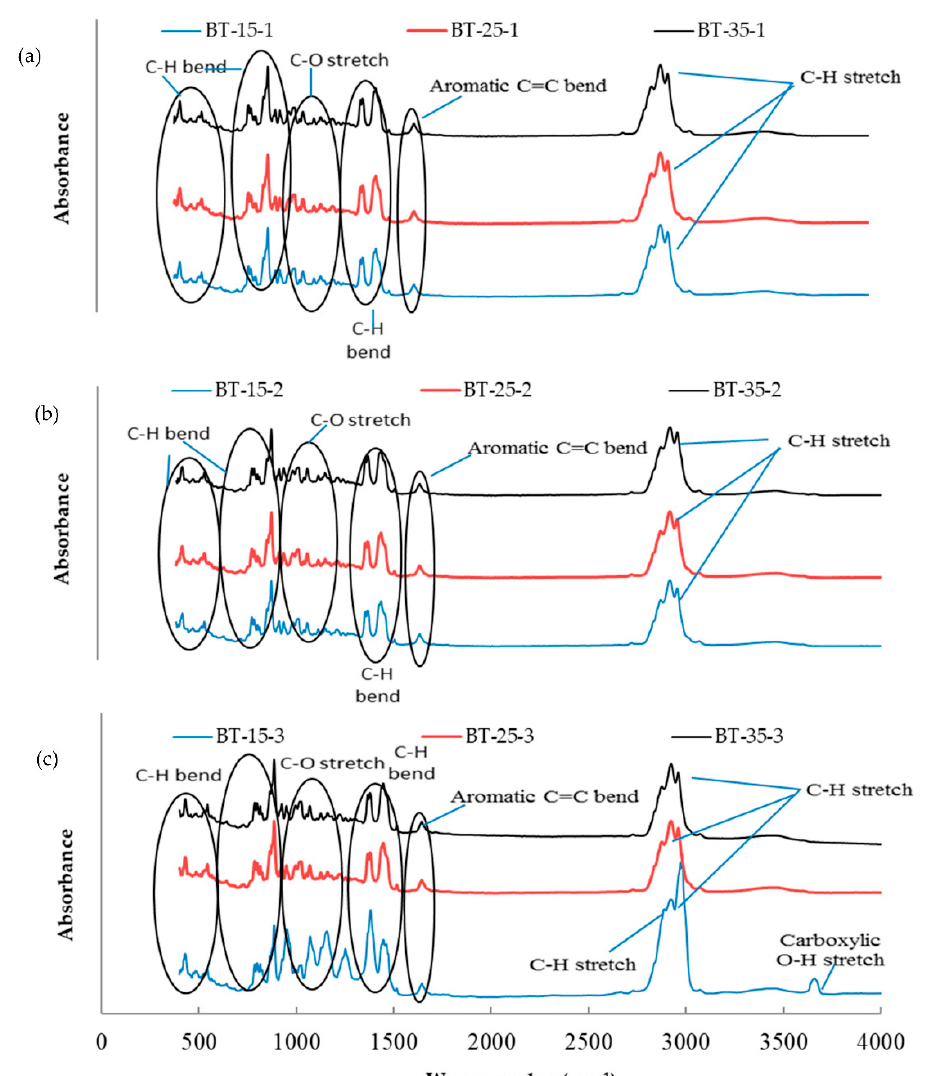
Figure 3. Fourier-transform infrared spectroscopy (FTIR) analysis for the essential oil combination of black pepper + tea tree (BT) at different temperatures (15, 25, and 35 °C) and different times of storage (1–3 months) (different colors refer to different temperature per subfigure). ( a ) This figure refer to the effect of different temperature at 15, 25, and 35 °C on the combination of BT stored for one month; ( b ) the second subfigure refer to different temperature at 15, 25, and 35 °C on the combination of BT stored for two months; ( c ) the third subfigure refer to different temperature at 15, 25, and 35 °C on the combination of BT stored for three months.